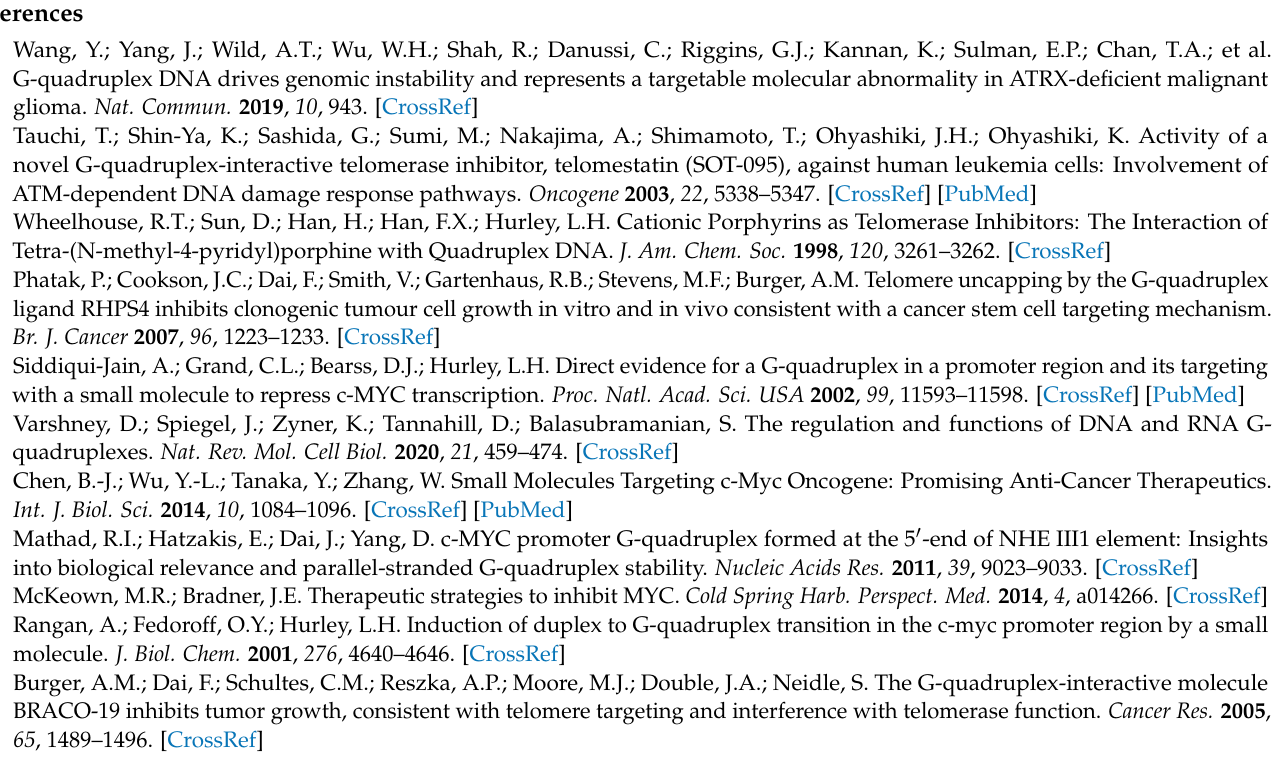
complexes. Figure S2: ESI-MS spectrum of compound 1b. Figure S3: ESI-MS spectrum of compound 2b. Figure S4: ESI-MS spectrum of compound 1. Figure S5: ESI-MS spectrum of compound 2. Figure S6: 1 H NMR spectrum of compound 1b in DMSO- d 6 . Figure S7: 1 H NMR spectrum of compound 2b in DMSO- d 6 . Figure S8: 1 H NMR spectrum of compound 1 in DMSO- d 6 . Figure S9: 1 H NMR spectrum of compound 2 in DMSO- d 6 . Figure S10: 13 C NMR spectrum of compound 1b in DMSO- d 6 . Figure S11: 13 C NMR spectrum of compound 2b in DMSO- d 6 . Figure S12: 13 C NMR spectrum of compound 1 in DMSO- d 6 . Figure S13: 13 C NMR spectrum of compound 2 in DMSO- d 6